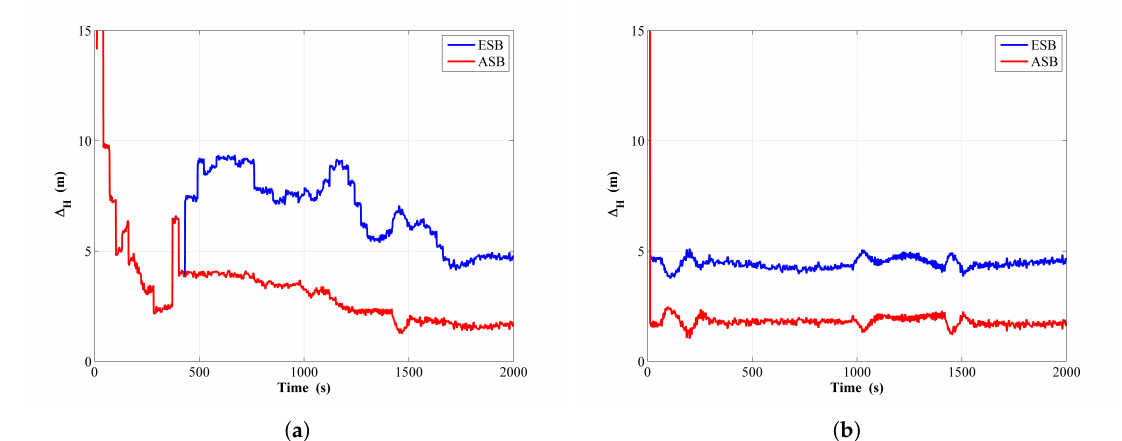
Figure 12. Horizontal distance error comparison between the ESB and the ASB algorithms using field data with unknown Q k : ( a ) Filter; ( b ) RTS smoother.